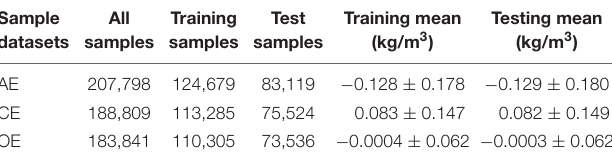
TABLE 1 | Sample statistics of training and testing